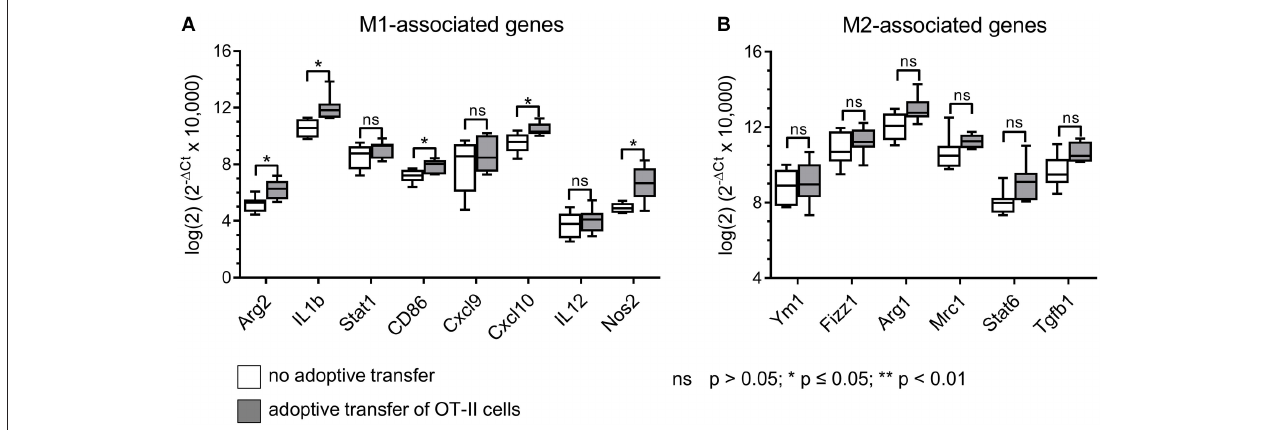
FIGURE 6 | Adoptive transfer of OVA-specific CD4 + T cells induces M1-like gene expression in TAMs of B16F10/M2KO/OVA tumors. Gene expression analysis of sorted TAMs from B16F10/M2KO/OVA tumors of mice adoptively transferred with OT-II cells revealed significantly increased expression of M1-associated genes (A) , while expression of M2-associated genes showed no significant changes (B) . The box and whiskers plots extend from the smallest to the largest values and show the median, the 25th and the 75th percentiles. Significance was determined using unpaired two-tailed Student’s t -test with Bonferroni-Holm p- value correction.